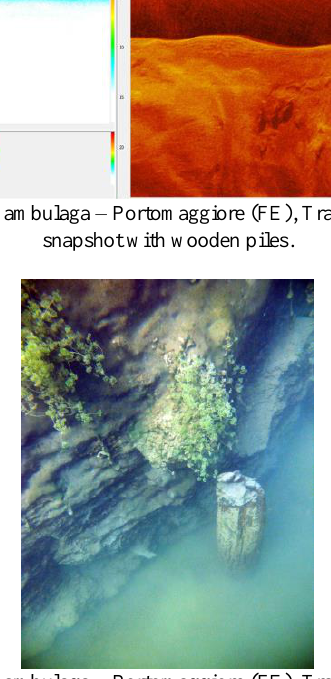
Figure 13. Gambulaga – Portomaggiore (FE), Tramonto Lake, wooden pile.